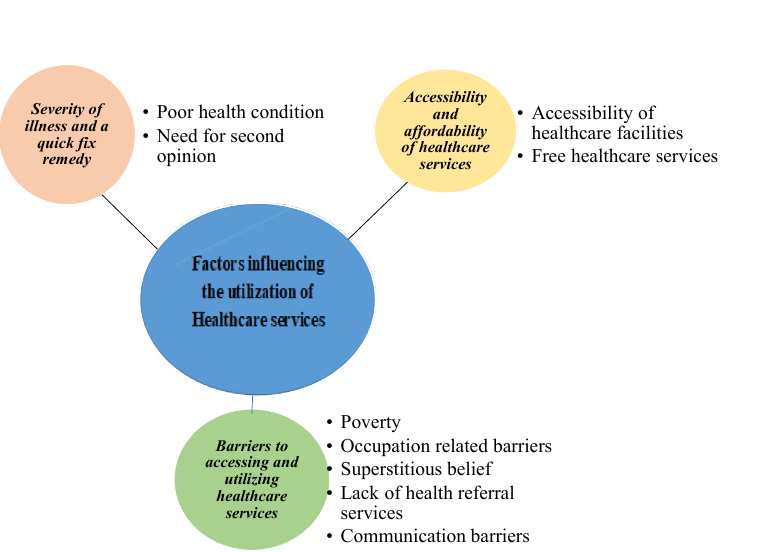
Figure 3. Utilisation of health